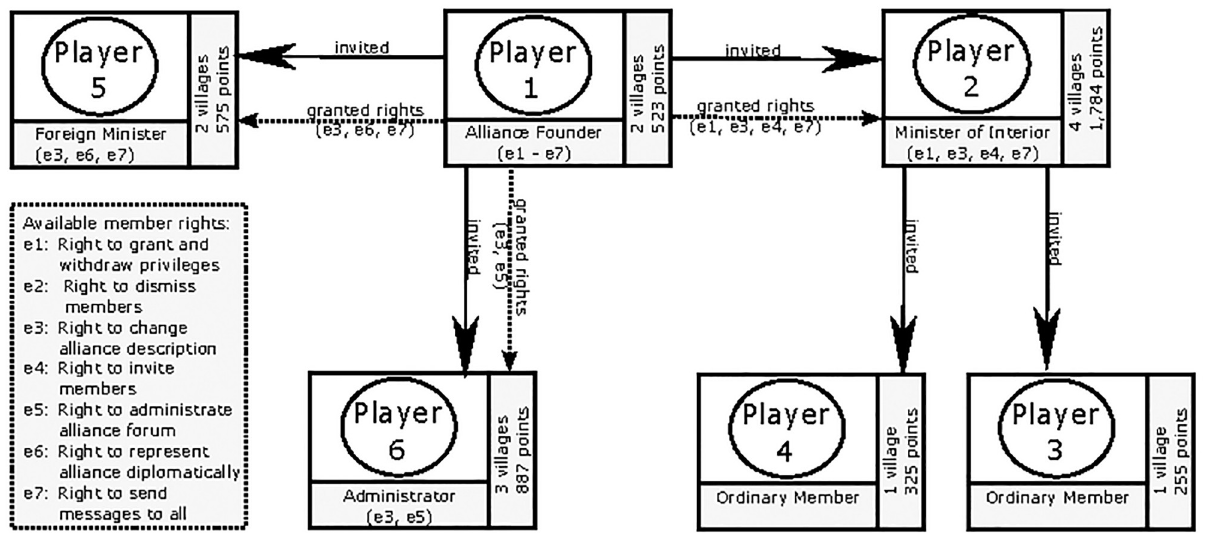
Fig 1. Teams in Travian are formed by the founder of thealliance, who initially holds all the power. To grow their alliance, the founder invites players to join the team. Here the founder can grant special rights to the new alliance members. These rights give these players the de facto power to fill different roles within the alliance. As players expand their villages, they earn additional points in the game ranking. The ranking of the alliances derives, in turn from the sum of the points of their individual members.